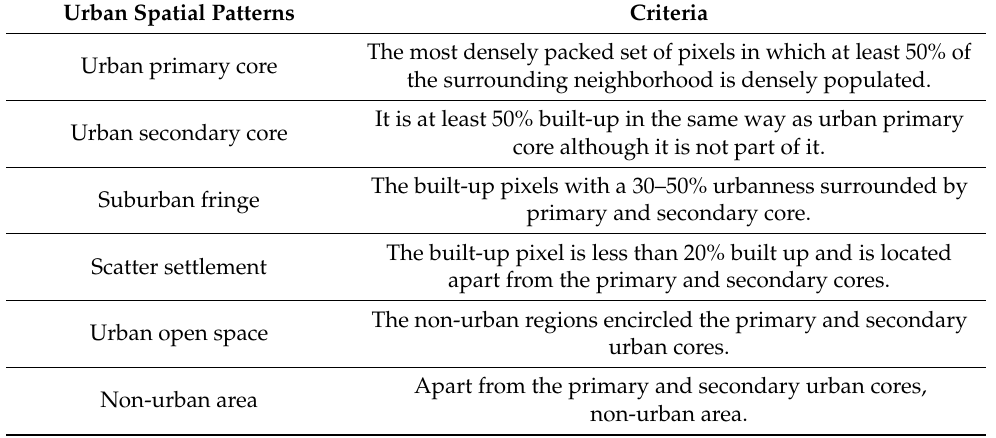
Table 2. Classification of the study area into urban spatial